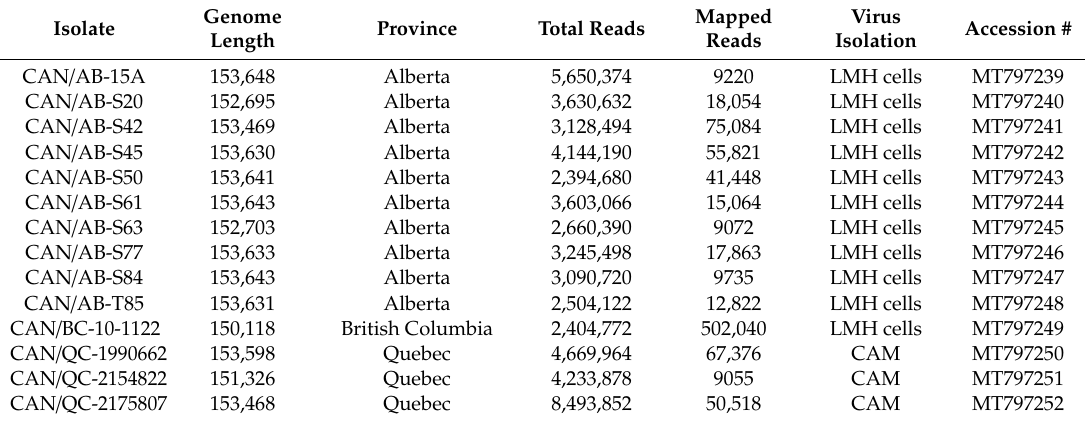
Table 2. Canadian ILTV full genome sequences ( n =